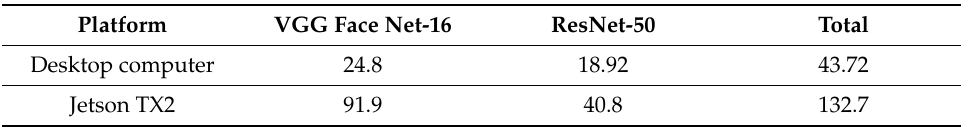
Table 16. Comparison of processing time on Jetson TX2 and desktop computer by VGG face net-16 and ResNet-50 (unit: